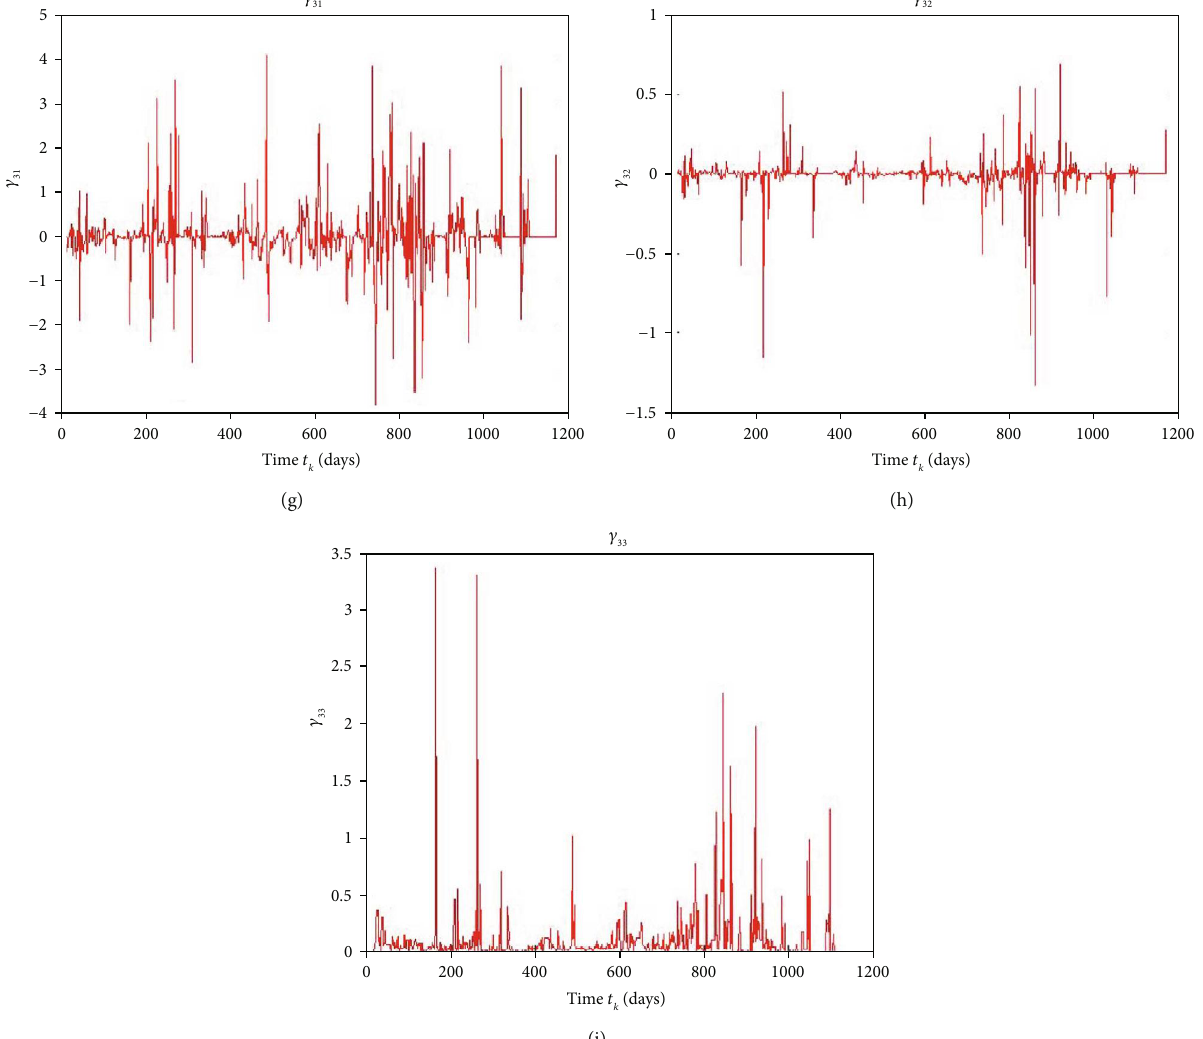
Figure 4: The graph of interaction coe ffi cients γ and γ